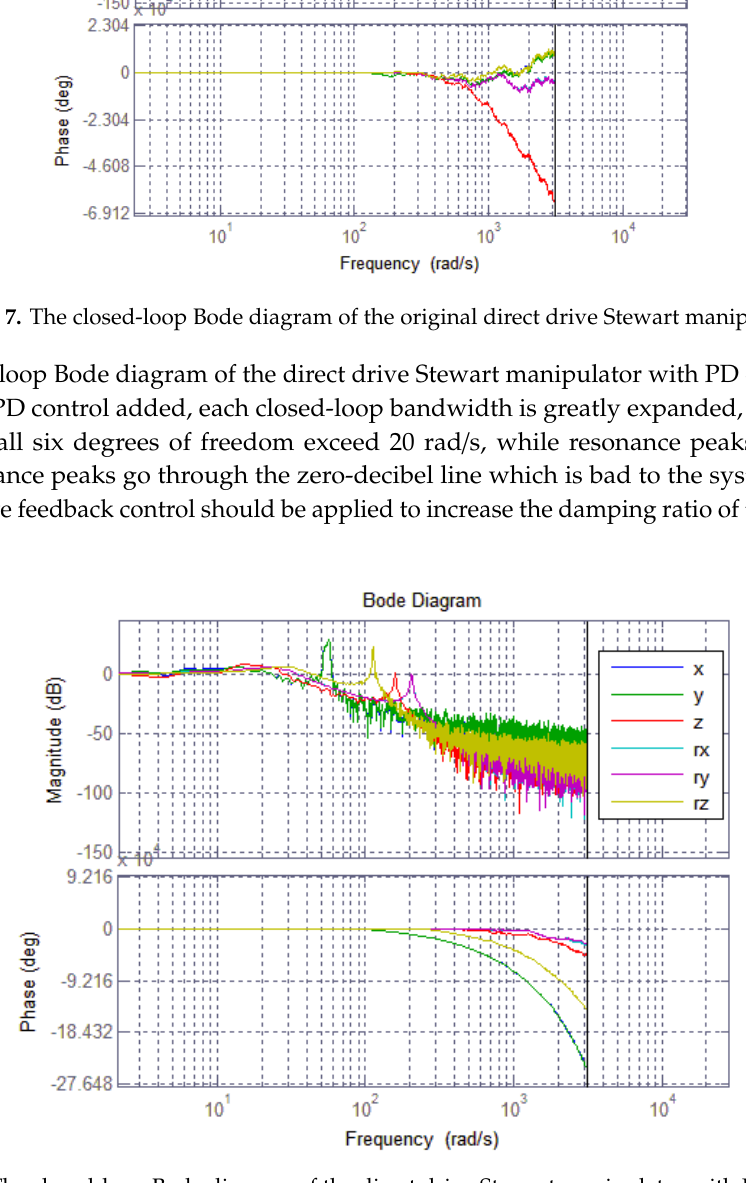
Figure 8. The closed ‐ loop Bode diagram of the direct drive Stewart manipulator with PD control.